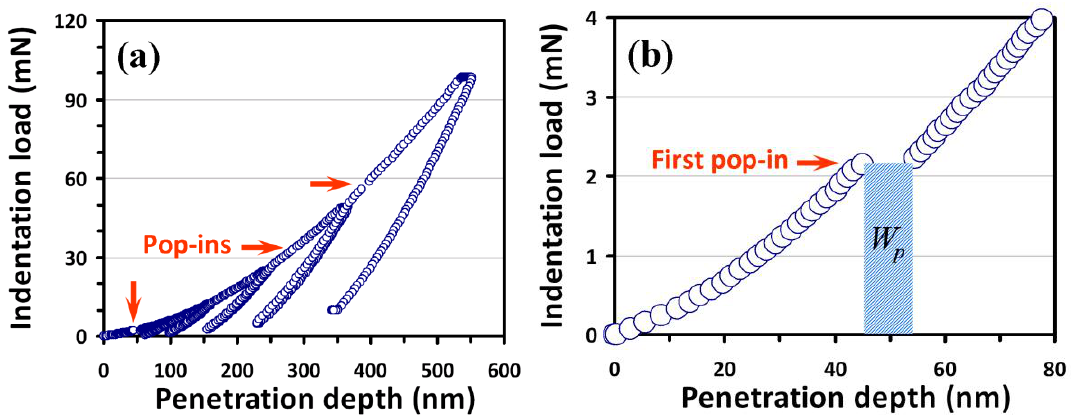
Figure 1. ( a ) Load-displacement curve measured by Berkovich indenter on AlN thin films at the indentation load of 100 mN and ( b ) the corresponding first pop-in event (see the arrow) from an expanded region of ( a ), where the plastic strain work is denoted as, W (critical loading times the sudden incremental displacement at constant